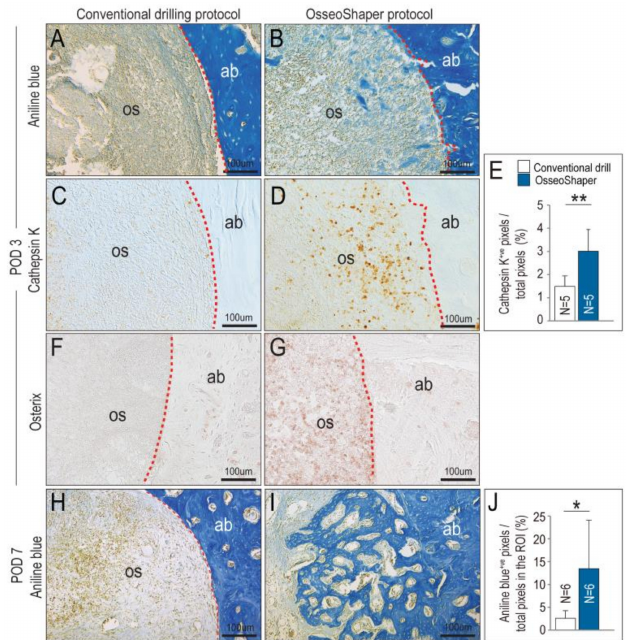
Figure 4. OsseoShaper drilling protocol promotes alveolar bone healing. Representative transverse tissue sections stained with aniline blue on post-osteotomy day 3 (POD3) following osteotomy site preparation with ( A ) conventional drills versus ( B ) the Nobel OsseoShaper. Note the presence of osseous coagulum in the osteotomy site prepared with the OsseoShaper. Adjacent tissue sections immunostained with Cathepsin K in the osteotomy sites of ( C ) conventional drills versus ( D ) the Nobel OsseoShaper. ( E ) Quantification of Cathepsin K +ve pixels/total pixels in the osteotomy site. Adjacent tissue sections immunostained with Osterix in the osteotomy sites of ( F ) conventional drills versus ( G ) the OsseoShaper. ( H ) Tissue sections stained with aniline blue show minimal new bone formation in conventional drill group, while ( I ) osteotomies in the OsseoShaper group show more new bone formation on POD7. ( J ) Quantification of aniline blue +ve pixels/total pixels in the osteotomy site. Dotted lines show the edge of the osteotomy. One asterisk indicates p < 0.05. Two asterisks indicate p < 0.01. Scale bars = 100 µ m. Abbreviations: as indicated